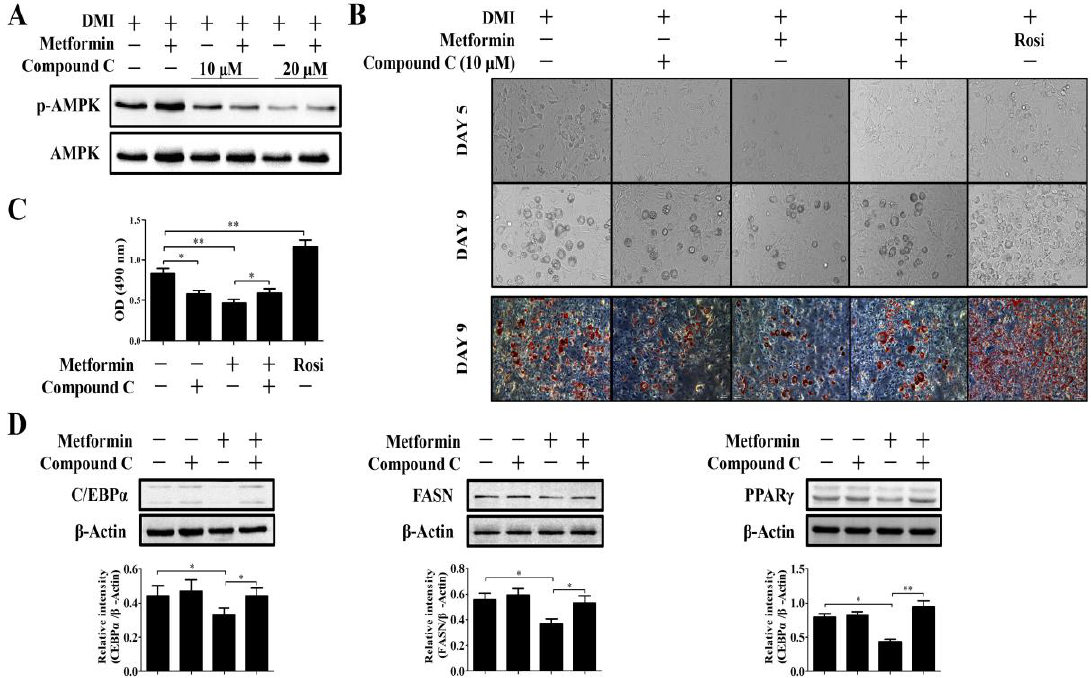
Figure 7. Effects of compound C on metformin-induced adipogenesis inhibition in 3T3-L1 cells. ( A ) Effects of compound C at 10 or 20 µ M on AMPK phosphorylation in 3T3-L1 cells treated with or without 5 mM of metformin ( n = 3); ( B ) Compound C at 10 µ M inhibited adipogenesis, but rescued metformin-induced inhibition of adipogenesis. After pretreated with or without 10 µ M compound C for 1 h, the 3T3-L1 preadipocytes were treated with DMI and metformin for the first two days, and the differentiation was continued for another 3 (Day 5) or 7 (Day 9) days, adipogenic differentiation was then determined by microscopic observation (200 × ) or Oil Red O staining (100 × ); ( C ) OD of quantified Oil Red O staining in 3T3-L1 cells ( n = 3); ( D ) Effects of compound C on 5 mM of metformin-induced inhibition of C/EBP α , FASN, and PPAR γ expression at day 9 ( n = 3). Cells were treated in the same way as above and the protein expressions were analyzed by Western blot. Blots were quantified using densitometry analysis and results were expressed relatively after normalization to β -Actin. Data represent the means ± SEM from three experiments. * p < 0.05 and ** p < 0.01 as compared between indicated treatments in graph (one-way ANOVA with post hoc Bonferroni’s correction ).